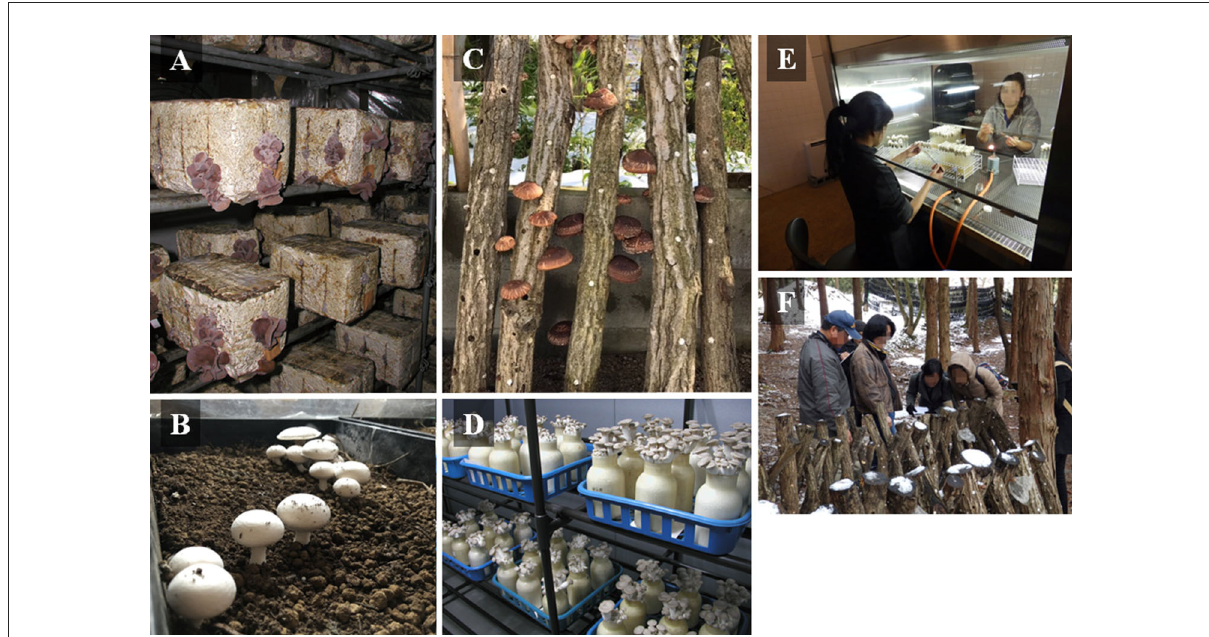
FIGURE1 “Bright” sides of mushroom production in sustainability. (A–D) Examples of mushroom cultivation using by-products of forestry and agriculture that contribute to environmental sustainability. Bag cultivation is currently the most commonly used cultivation method in global mushroom production. (A) Bag cultivation of wood-ear mushroom using broadleaved tree sawdust and wheat bran. (B) Bed cultivation of button mushroom using horse manure and paddy straw. (C) Log cultivation of shiitake mushroom using broadleaved tree logs. (D) Bottle cultivation of king trumpet mushroom using conifer tree sawdust and wheat bran. (E,F) Examples of educational and technical assistance to developing countries (As part of the Japan International Cooperation Agency Partnership Program “Livelihood Improvement of Mushroom Farmers in Western Bhutan,” at the Tottori Mycological Institute, 2018). (E) Training for sterile technique on clean bench. (F) Inspection of log cultivation of shiitake